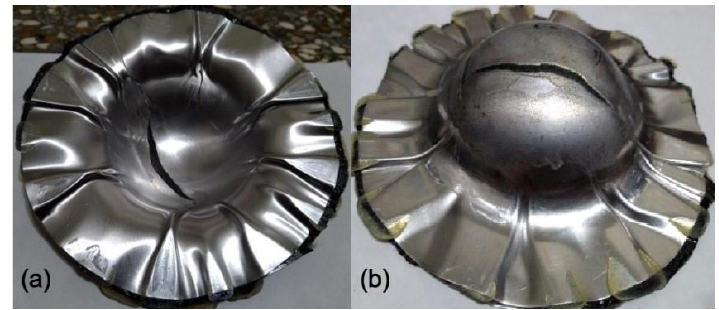
Figure 9. Deep drawing of Al 6061-composite sandwich: ( a ) front view, ( b ) back view.